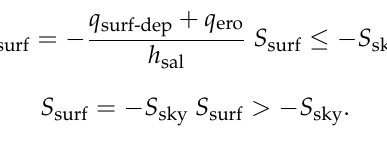
Figure 11. Cell generation of the gable roof: ( a ) ground and building surfaces; ( b ) central section of the building.